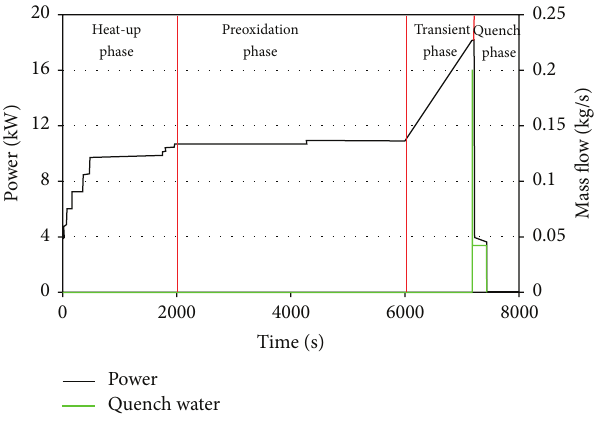
Figure 4: Total electrical power input of QUENCH-06 experiment [16].